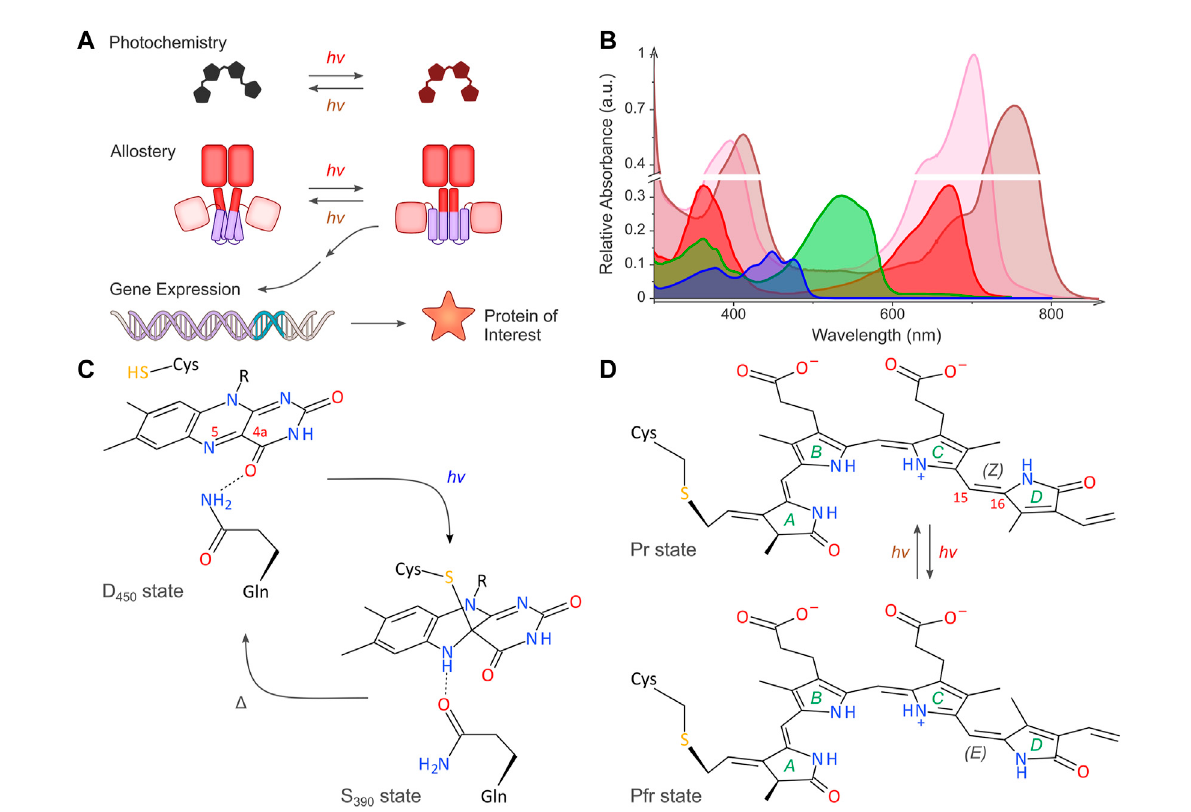
FIGURE 1 Light-regulated gene expression in bacteria. (A) The schematic depicts the basic principles of the optogenetic regulation of bacterial gene expression. Sensory photoreceptors harbor chromophores that undergo photochemical reactions in response to light absorption. The photochemical level is coupled to allosteric transitions within the protein moiety that culminate in altered photoreceptor activity. In turn, the light- induced activity change prompts the bacterial expression of the protein of interest. As illustrated in the scheme, certain photoreceptors are photochromic and can be bidirectionally toggled by two light colors. (B) Representative absorbance spectra of select sensory photoreceptors, with light-oxygen-voltage (LOV) and BLUF receptors shown in blue, the paradigm cyanobacteriochrome (CBCR) CcaS in green (Pg state) and red (Pr state), and bacterial phytochromes (BphP) in pink (Pr state) and brown (Pfr state). The spectra are scaled to re fl ect the individual peak extinction coef fi cients, i.e., around 12,500 M − 1 cm − 1 , 30,000 M − 1 cm − 1 , and 90,000 M − 1 cm − 1 for LOV/BLUF, CBCR (Pg), and BphP (Pr), respectively. (C) Simpli fi ed photochemistry of LOV receptors. Upon absorption of blue light by the dark-adapted state D 450 , a covalent adduct forms between atom C4a of the fl avin chromophore and the S γ atom of a conserved cysteine residue. The resultant protonation of the N5 atom within the signaling